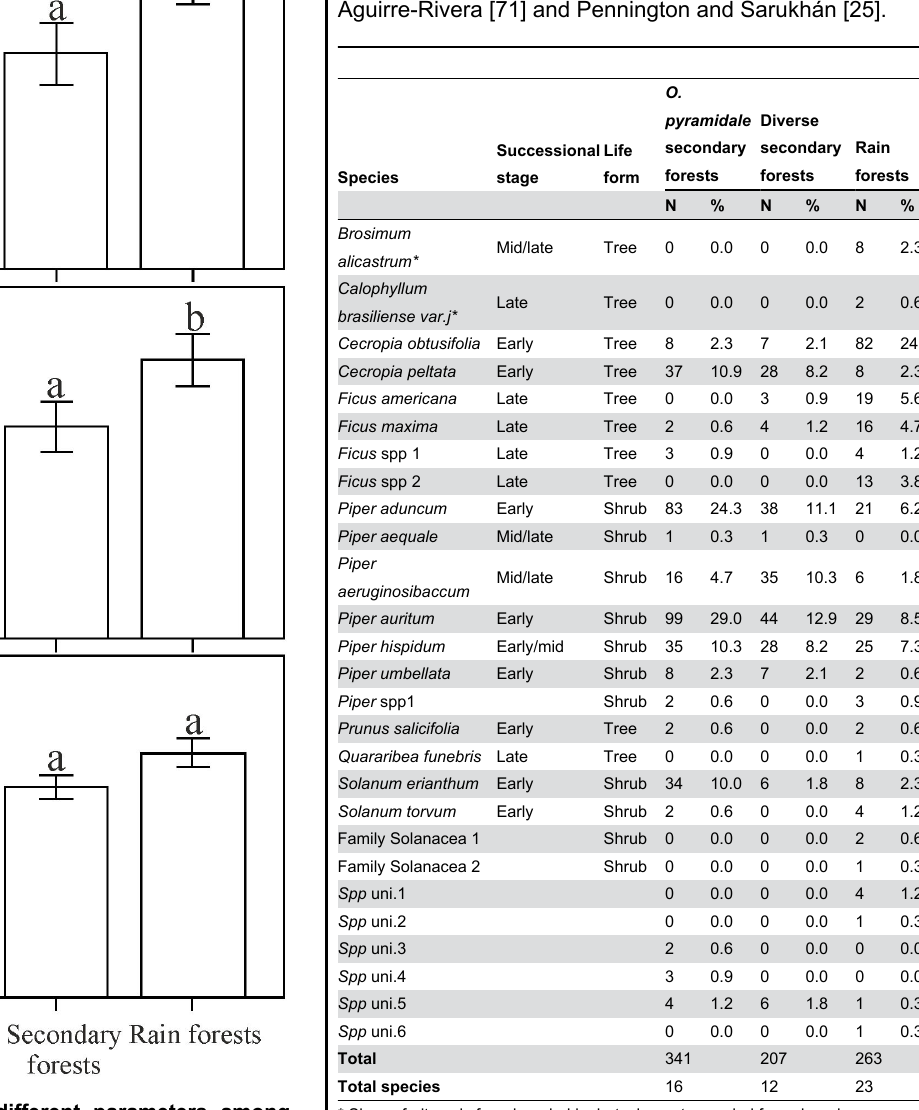
Table 2. Number of plant species recorded from fruits consumed by frugivorous bats, successional categories and life form follows Greig [69], Guevara [70], Levy-Tacher and Aguirre-Rivera [71] and Pennington and Sarukhán